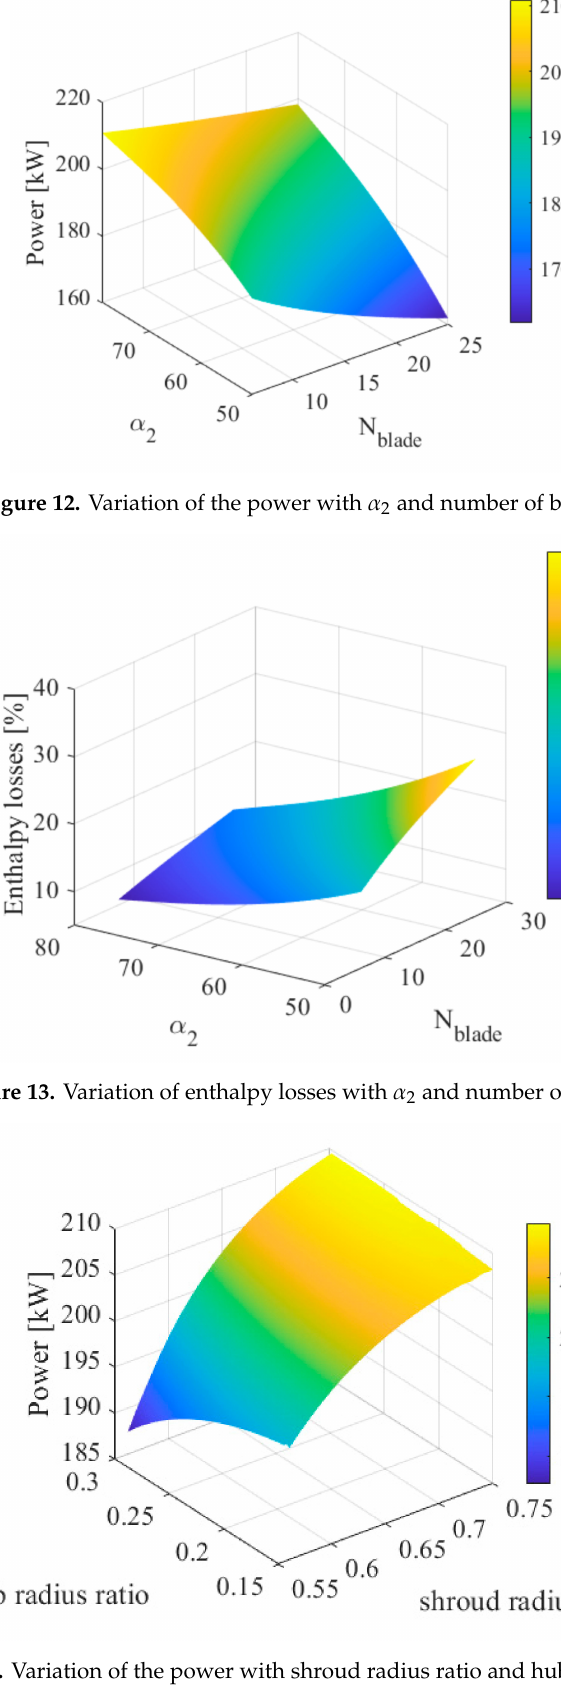
Figure 14. Variation of the power with shroud radius ratio and hub radius